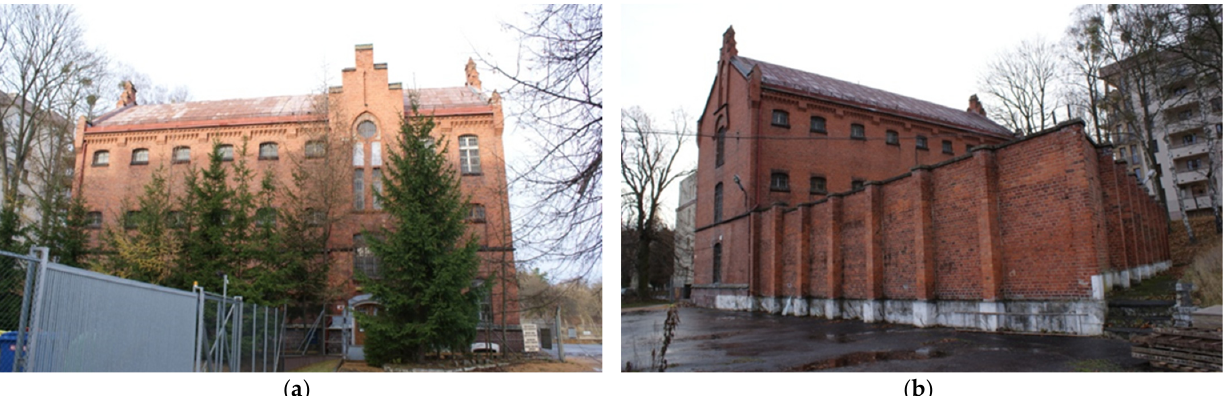
Figure 2. Building of the garrison jail: ( a ) from the south, ( b ) from the north-eastern with the perimeter wall encircling the prison yard.